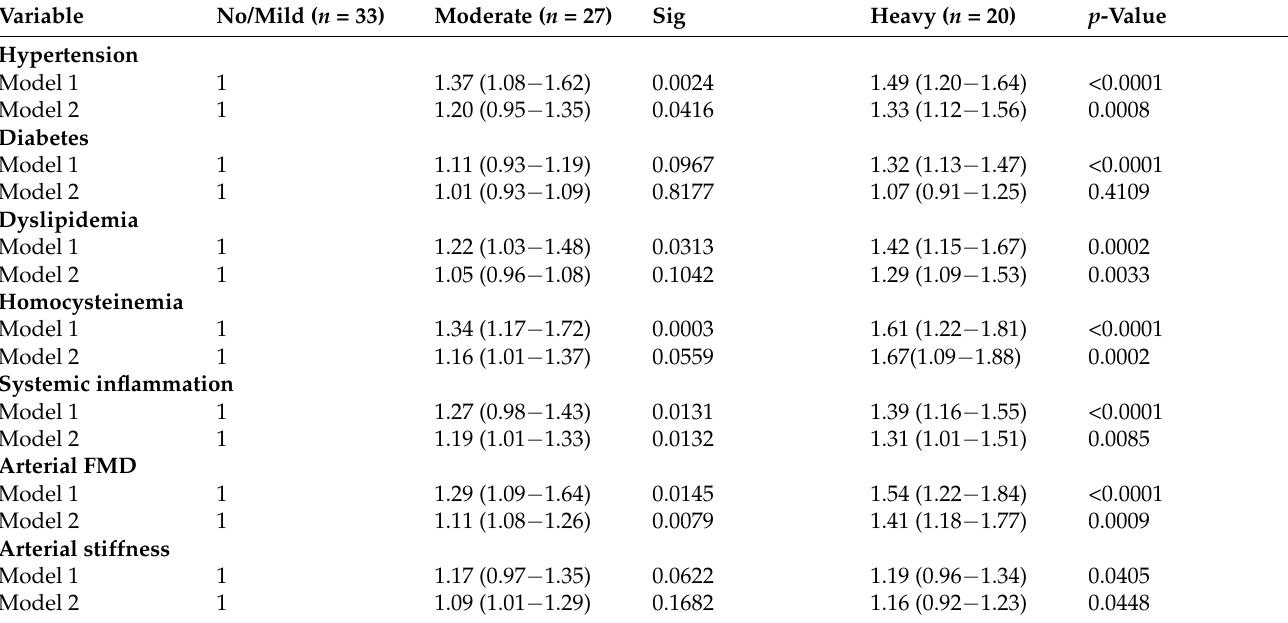
Table 3. Likelihood of cardiometabolic risk factors in relation to alcohol consumption